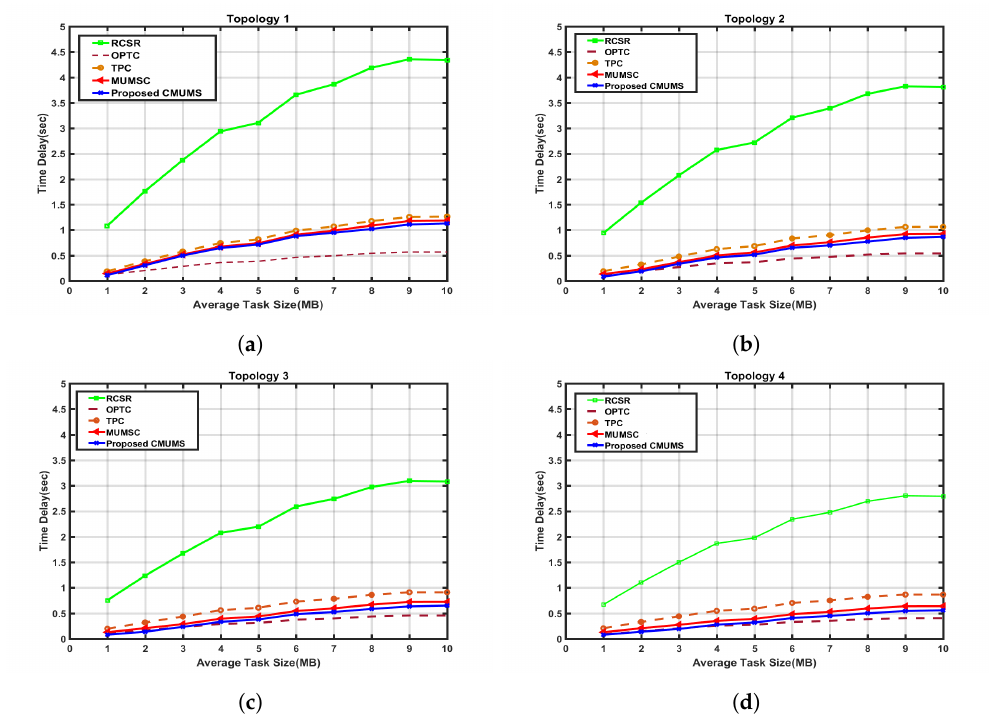
Figure 6. Time Delay vs. Average Task Size in four topology structures. ( a ) Time delay vs. Average task in 1st topology; ( b ) Time delay vs. Average task in 2nd topology; ( c ) Time delay vs. Average task in 3rd topology; ( d ) Time delay vs. Average task in 4th topology.